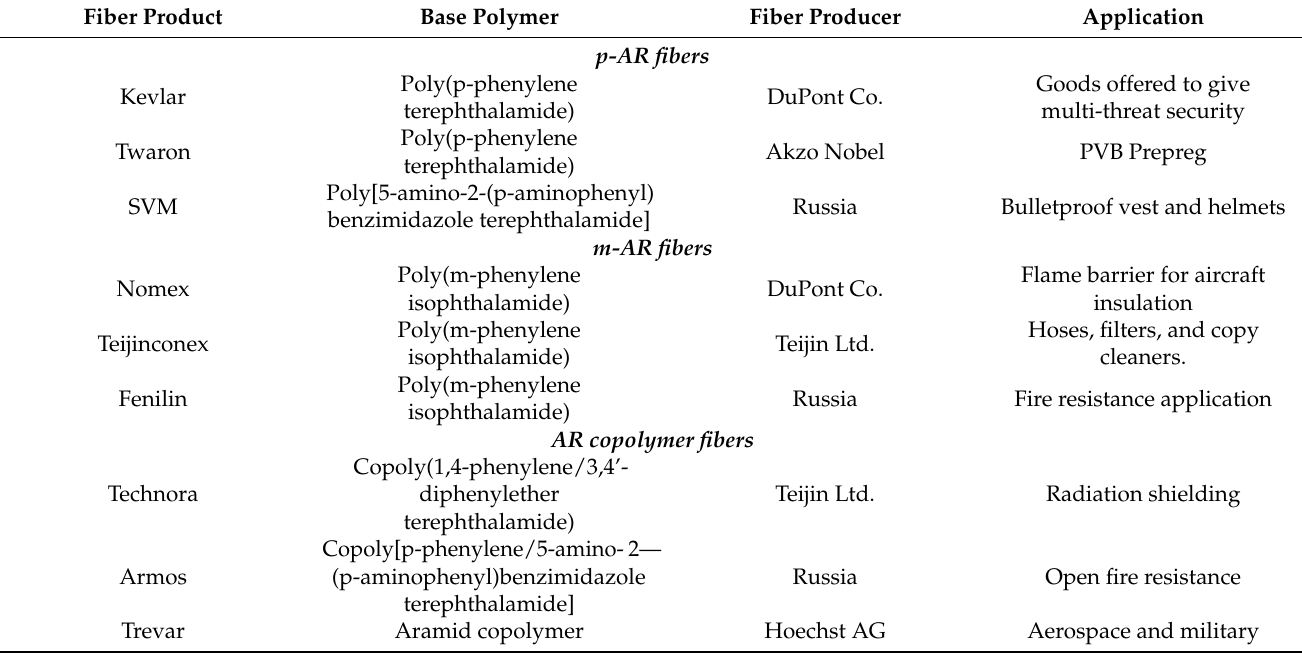
Table 2. Global manufacturing of AR fibers [43].